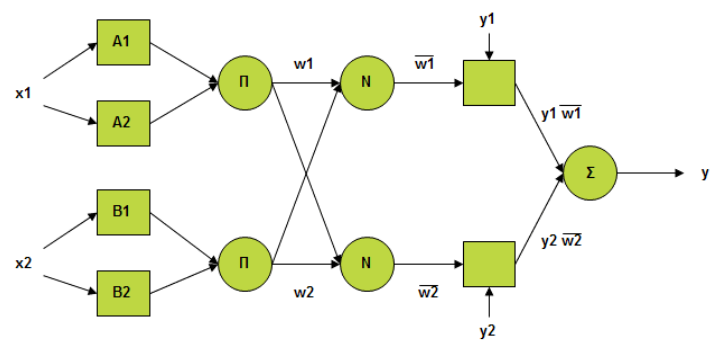
Figure 2. A general illustration of Adaptive Neuro-Fuzzy Inference System (ANFIS).